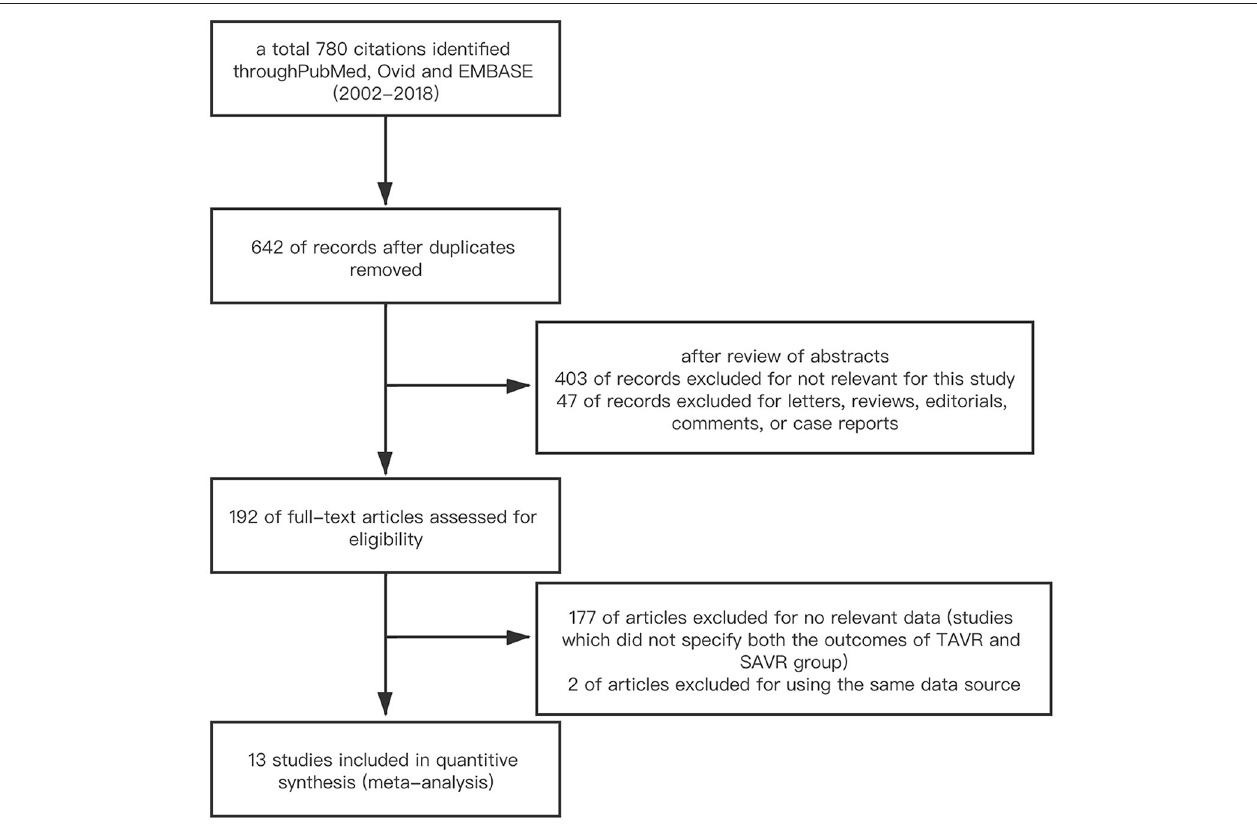
FIGURE 1 | Flow diagram of study